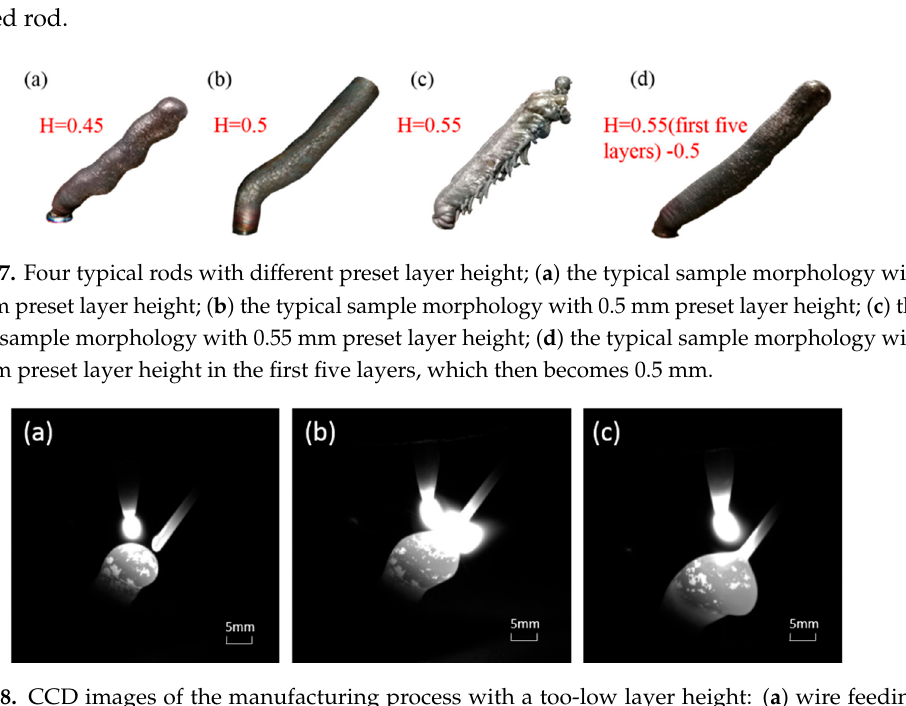
Figure 8. CCD images of the manufacturing process with a too-low layer height: ( a ) wire feeding; ( b ) peak time; ( c ) the droplet is squeezed and bent.